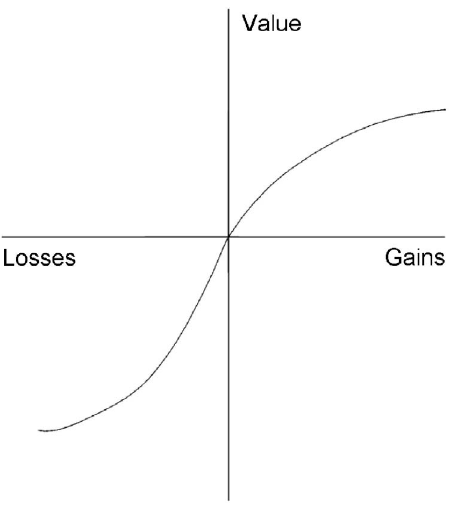
Figure 1. Prospect theory’s value function for gains and losses.